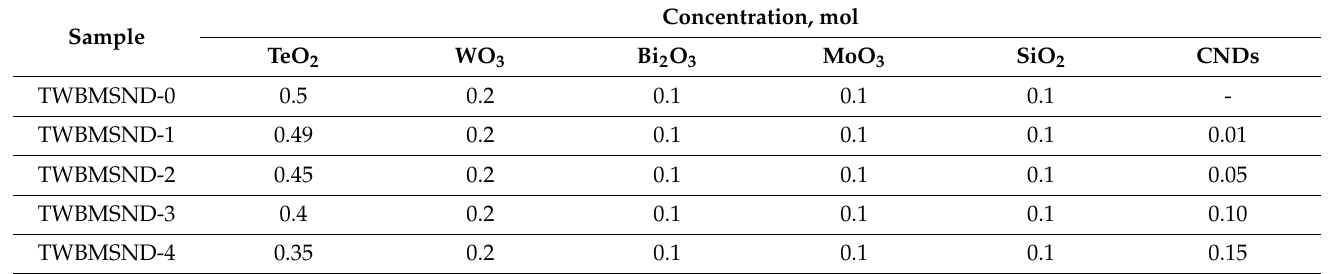
Table 1. Designation of samples according to the concentration of the components of the glass